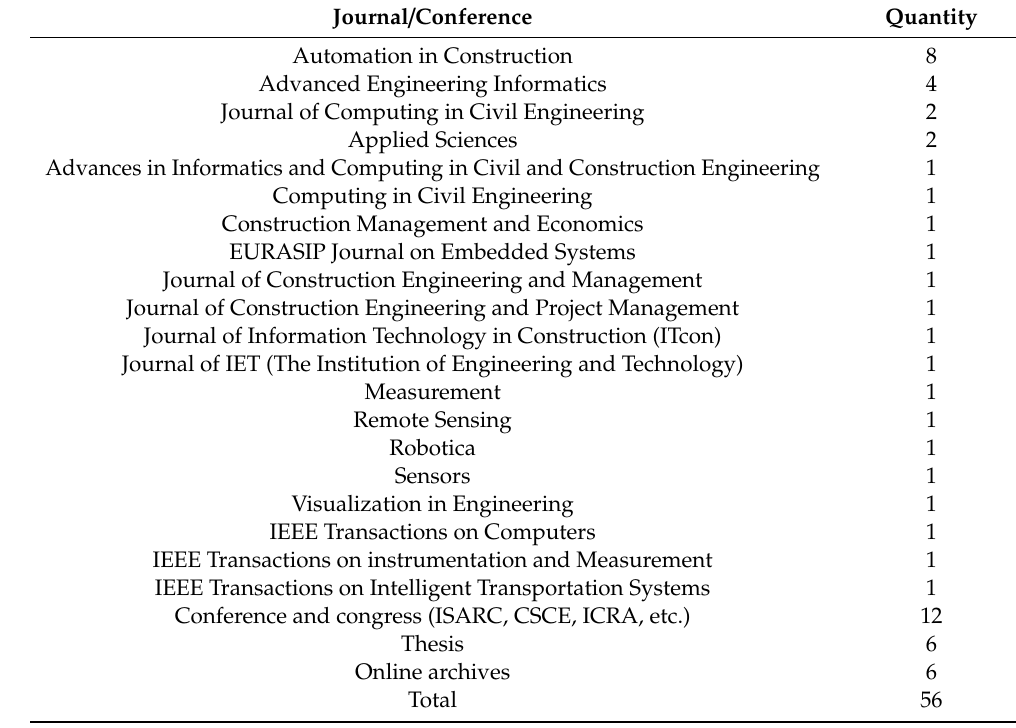
Table 1. Source journals, conferences, and the publications used in this